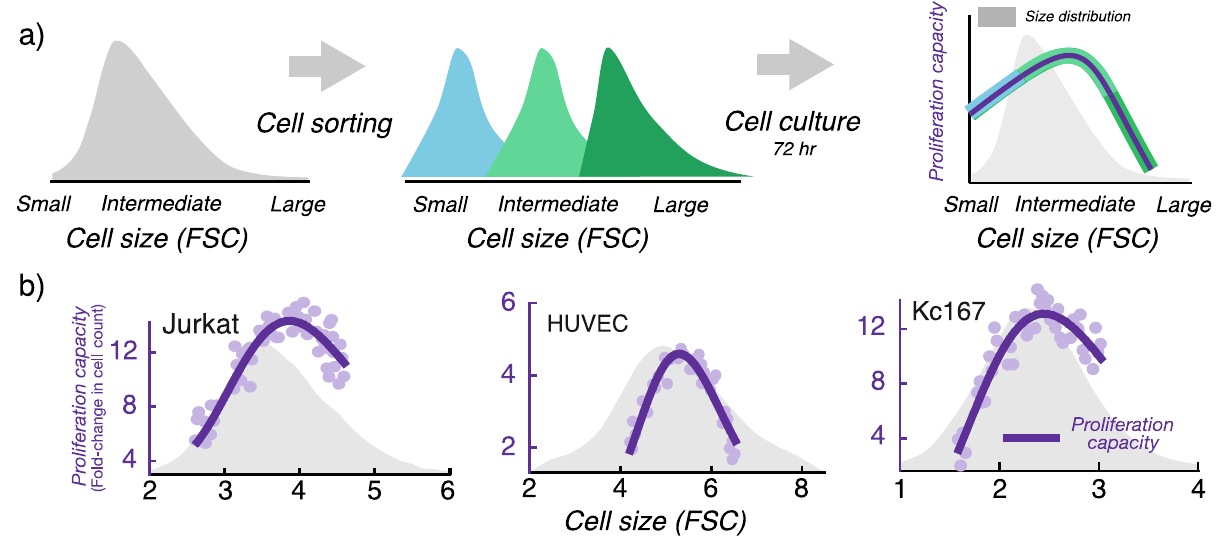
Figure 1. Cellular proliferation capacity is maximized at a target cell size. ( a ) Using forward scatter intensity (FSC) as a proxy for cell size 1,2 , flow cytometry is used to sort an original unsynchronized cell population (grey) into several subpopulations with different cell sizes. Each subpopulation is cultured for 72 h (approximately 3–5 cell generations), and proliferation capacity is quantified by measuring the relative change in cell counts. Interested readers are referred to the material and methods of 1 for further details. ( b ) Measured proliferation capacity is plotted as a function of the average subpopulation FSC at the time of sorting for three different cell types: Jurkat cells (human T lymphocyte cell line), HUVEC (human umbilical vein endothelial cells; a primary cell line) and Kc167 (a widely used Drosophila cell line). The original cell size distribution is shown in grey. Experimental data presented here was taken from Fig. 3D of Miettinen and Björklund, Developmental Cell, 2016 1